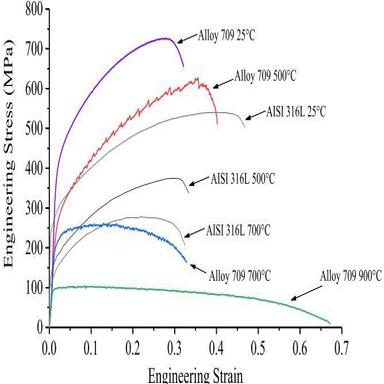
Engineering stress-strain curves of alloy 709 at 25 C, 500 C, 700 C and 900 C performed compared with AISI 316L .